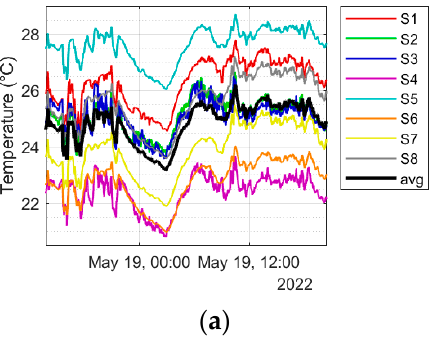
Figure 2. Measurements carried out by eight BMP280 sensors: ( a ) temperature; ( b ) pressure.